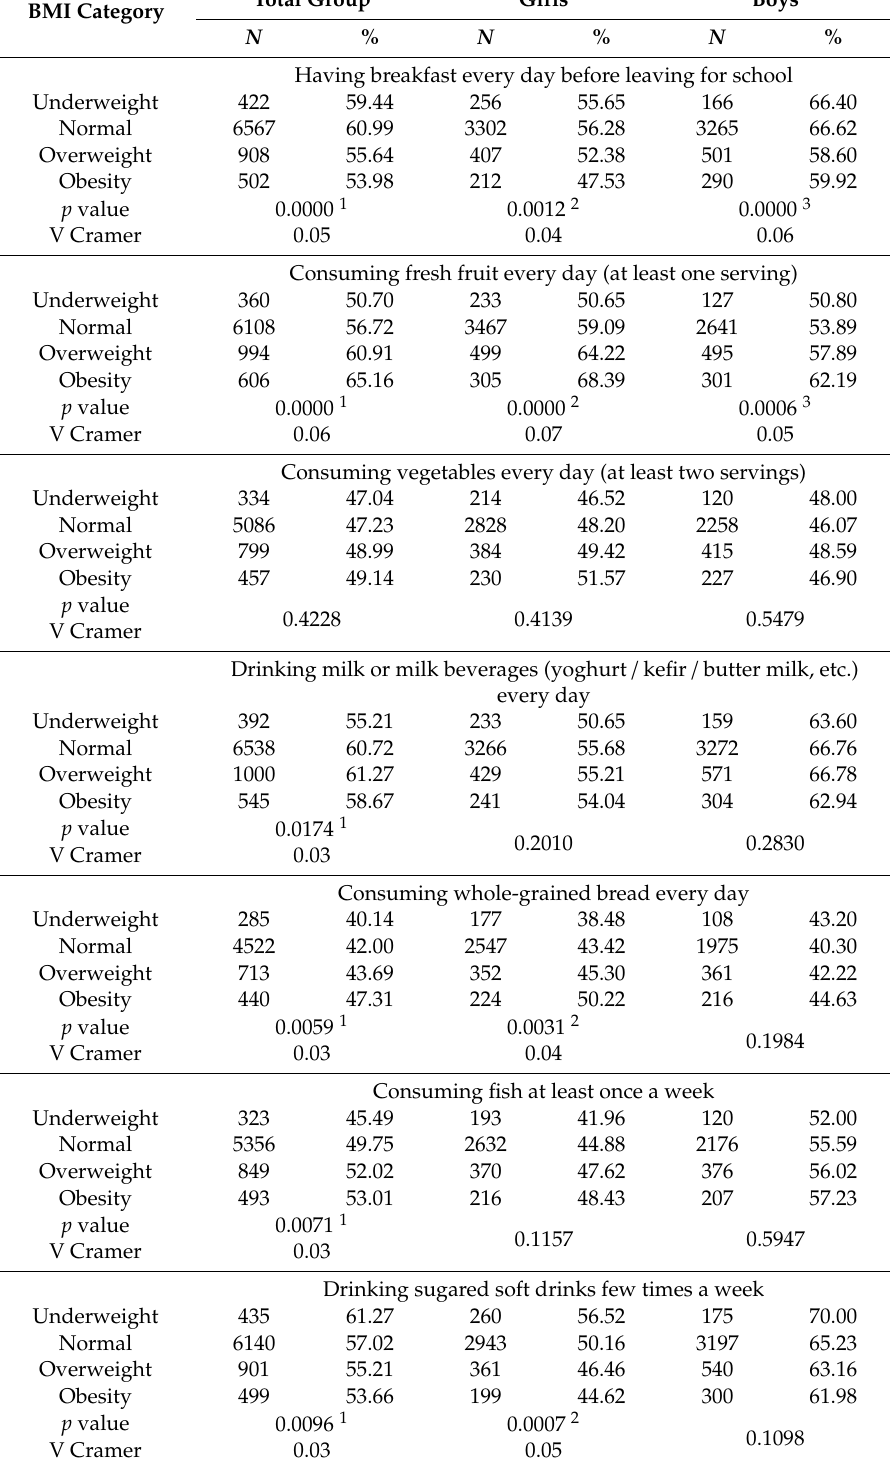
Table 3. Nutritional behaviors of the individuals depending on body weight status: In the total group and divided by